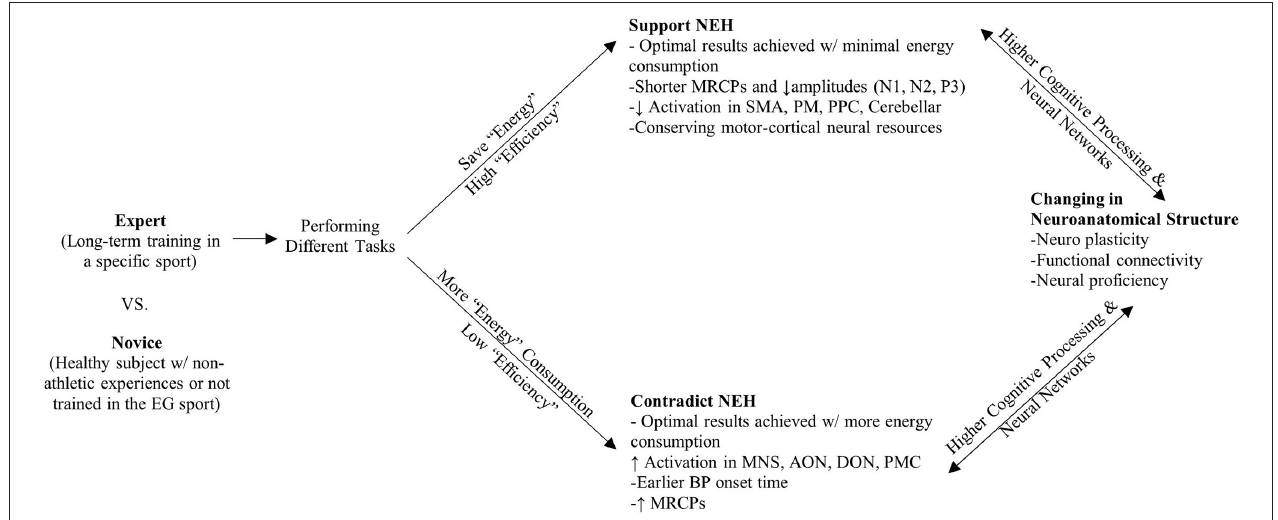
FIGURE 2 | Schematic overview of neural efficiency in athletic brain.